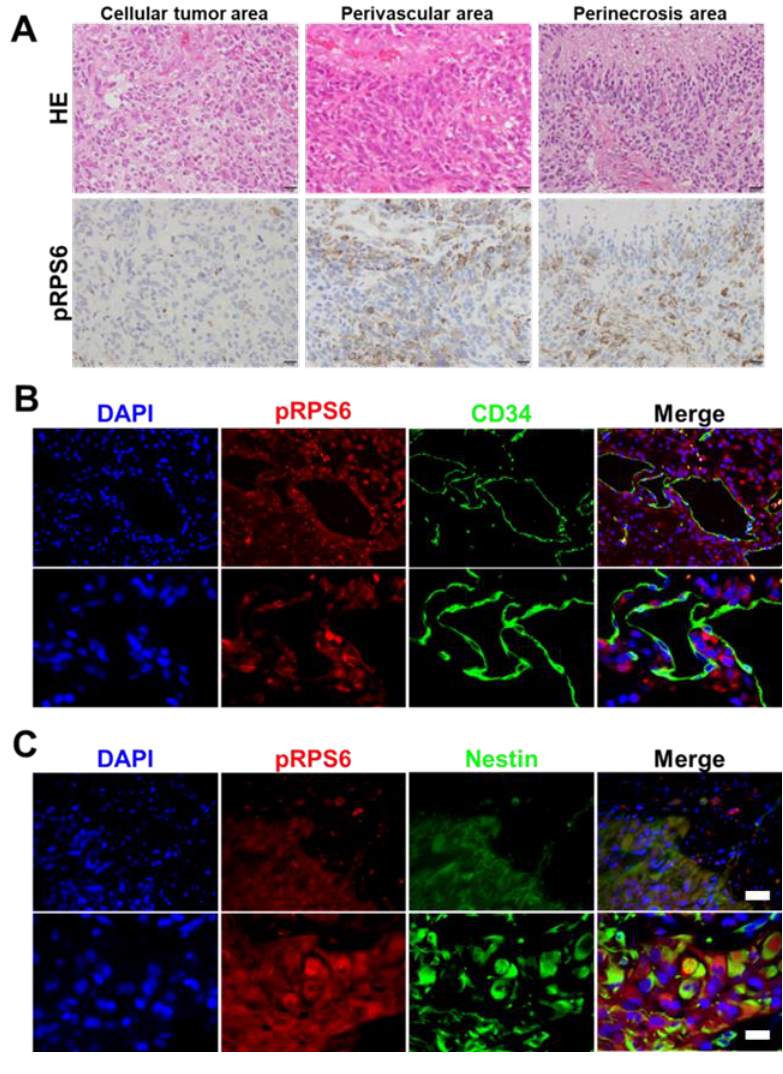
Figure 5. Possible association between RPS6 phosphorylation and GSC in glioma tissues. ( A ), Images showing higher expression of pRPS6 detected in the perivascular and perinecrosis area compared with the cellular tumor area. Bar: 20 µm. ( B , C ), Images showing double staining with pRPS6, CD34, and Nestin. Bar: 500 µm (each down-scale picture), 50 µm (up-scale picture).